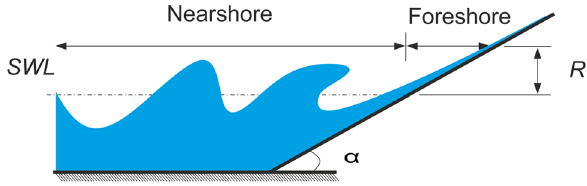
Figure 1. A schematic presentation of wave run-up on the